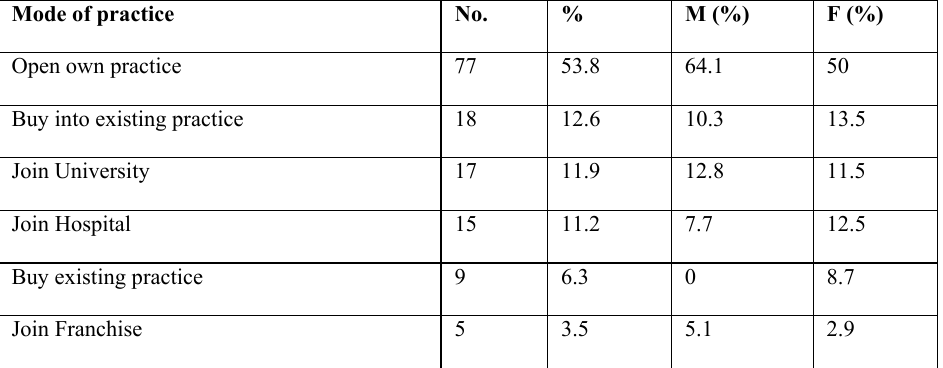
Table 7: Showing the most likely mode of practice that will provide the greatest fulfilment for their professional goal within the next ten years. Opening one’s own practice was the most common choice and joining franchises is the least common choice